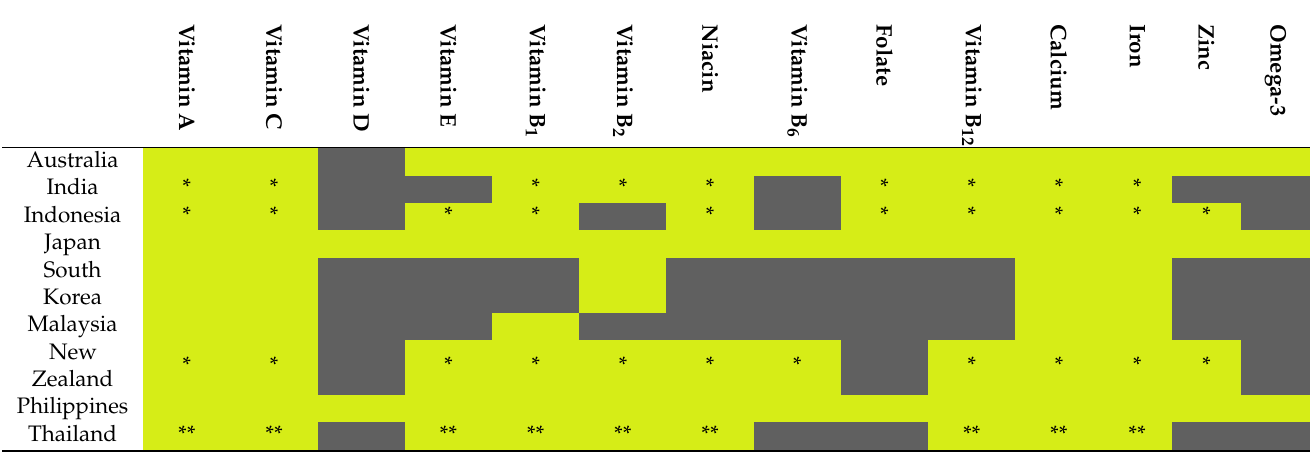
Table 3. The availability of micronutrient intake data from national